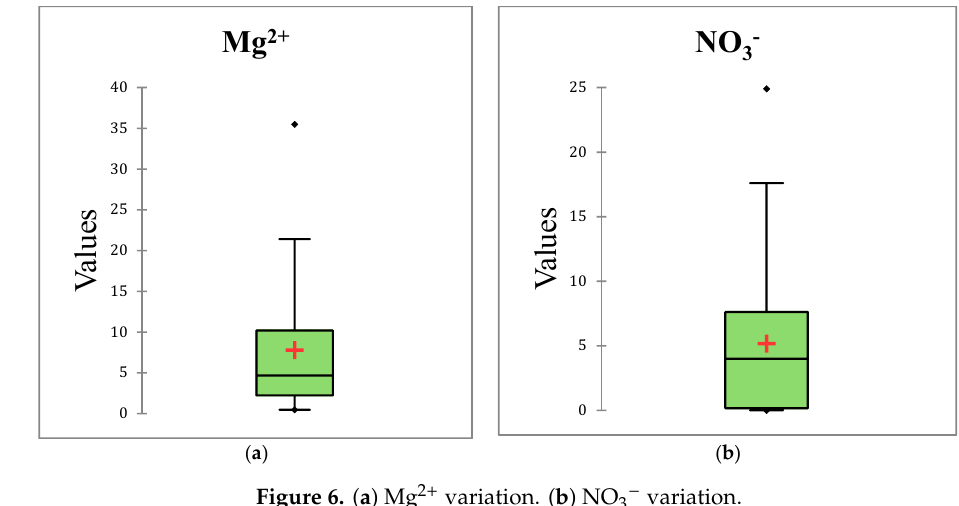
( b ) Figure 5. a )Sulfate SO 42- variation. b ) HCO 3 − variation. ●